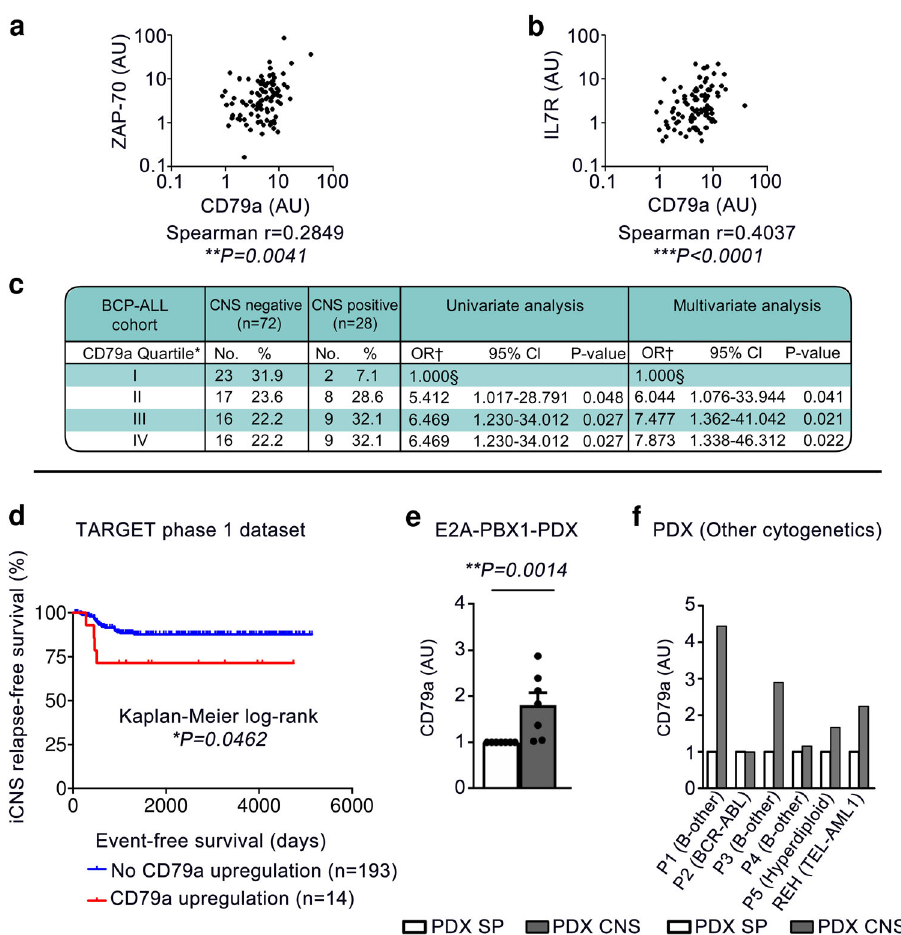
Fig. 1 CD79a has independent prognostic relevance for CNS-involvement and CNS-relapse in BCP-ALL patients. a – c CD79a mRNA levels and further genes (all normalized to mRNA levels in the 697 cell line) were measured in diagnostic BM samples in a selected cohort of 100 pediatric BCP-ALL patients of mixed cytogenetics which contained 28 CNS-positive patients matched to 72 CNS-negative patients of corresponding sex and age 5 . a , b Bivariate correlation analysis between CD79a expression and a ZAP70 and b Interleukin-7-receptor (IL7R) were performed, Spearman correlation (two-tailed, respective 95% con fi dence interval (CI) [0.08789, 0.4605] and [0.2174, 0.5616]). c Univariate and multivariate logistic regression analysis for risk of initial CNS-involvement, controlled for age and white blood cell (WBC) count at diagnosis as well as TEL-AML and BCR-ABL positivity. * Based on expression as measured by RT-PCR of patient material at initial diagnosis. † Multivariate OR controlled for age and WBC count at diagnosis as well as TEL- AML and BCR-ABL positivity. § Reference category. De fi nitions of patient CNS status in Supplementary Material d Kaplan – Meier survival curve showing reduced isolated CNS-relapse-free survival in children with upregulated CD79a gene expression in diagnostic BM/peripheral blood (upregulation is de fi ned as z -score for gene expression ≥ 1.2 which is equivalent to the 11.5% top CD79a-expressing patients; TARGET phase 1 dataset). e E2A-PBX1 + BCP-ALL blasts from seven different patient-derived xenograft (PDX) samples were injected into NSG mice ALL cells were recovered from spleen (SP) and CNS and subjected to quantitative real-time PCR (qPCR). QPCR shows the upregulation of CD79a at the transcription level in PDX cells recovered from the CNS relative to cells isolated from Sp, Mann – Whitney- U test, two-tailed, graphs show mean with standard error of n = 7 independent samples. f An upregulation of CD79a was also observed in CNS-BCP-ALL cells compared to SP-BCP-ALL cells in NSG-mice injected with bone marrow cells from BCP- ALL patients of different cytogenetic backgrounds ( n = 5 independent patient samples) or CNS-tropic REH cells (TEL-AML1) as determined via qPCR. Relative quanti fi cation of CD79a mRNA levels normalized to 697 cells are shown for individual patients, P Patient, AU Arbitrary units. * P < 0.05, ** P ≤ 0.01, *** P ≤